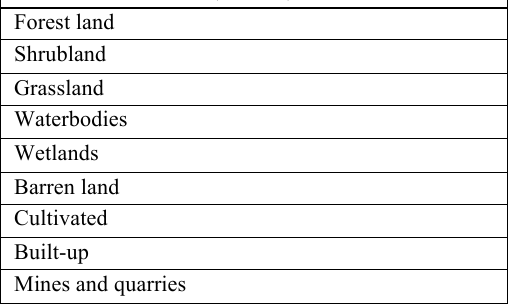
Table 1. Land cover classes (CD: NGI)